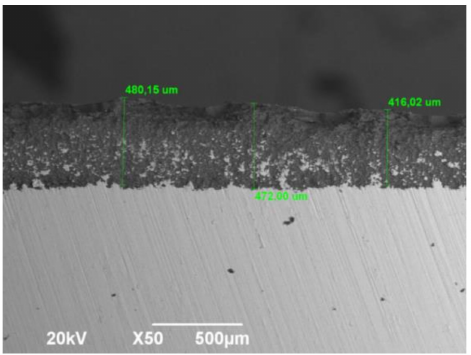
Figure 4. SEM micrographs of the alumina SEM image of alumina deposited on Inconel 718. X-ray diffraction patterns of Al 2 O 3 /SiO 2 -ZrO 2 and Al 2 O 3 coatings both deposited